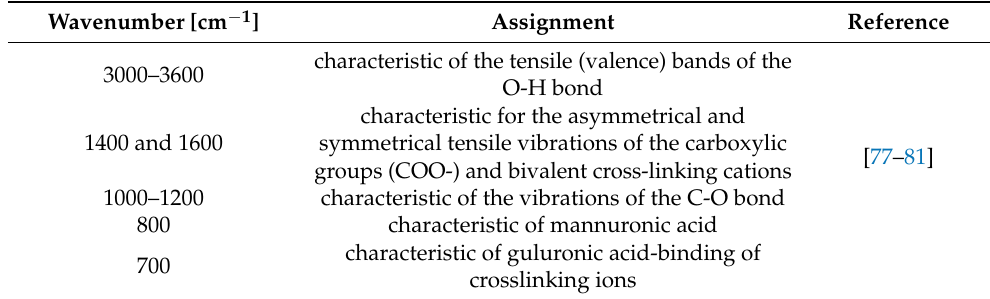
Figure 2. FTIR-ATR spectrum for alginate sodium samples with a concentration of alginate 70 mg. ml cross-linked with 1.5 molar barium chloride (A70) and alginate-Pygeum (PYG/A70). The spectrum shows the characteristic peaks shown in Table 2. Table 2. Characteristic IR peaks obtained for the tested